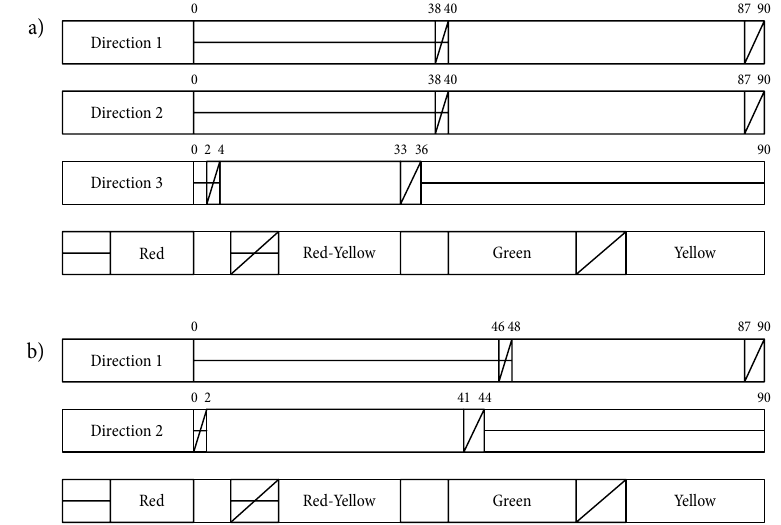
Fig. 3. Signal timing plan: a – 3-leg intersection; b – 4-leg